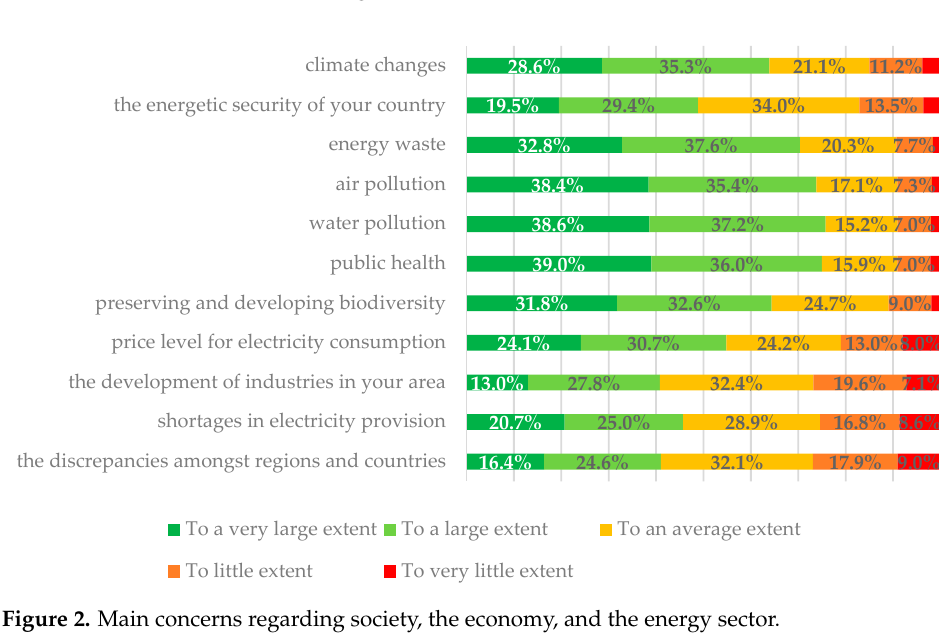
Figure 2. Main concerns regarding society, the economy, and the energy sector. Table 5. Political orientation. The political orientation and social values of respondents were measured through self-evaluation on a right-left/conservative-liberal political spectrum, as demonstrated in Tables 5 and 6. Table 6. Conservative vs. liberal